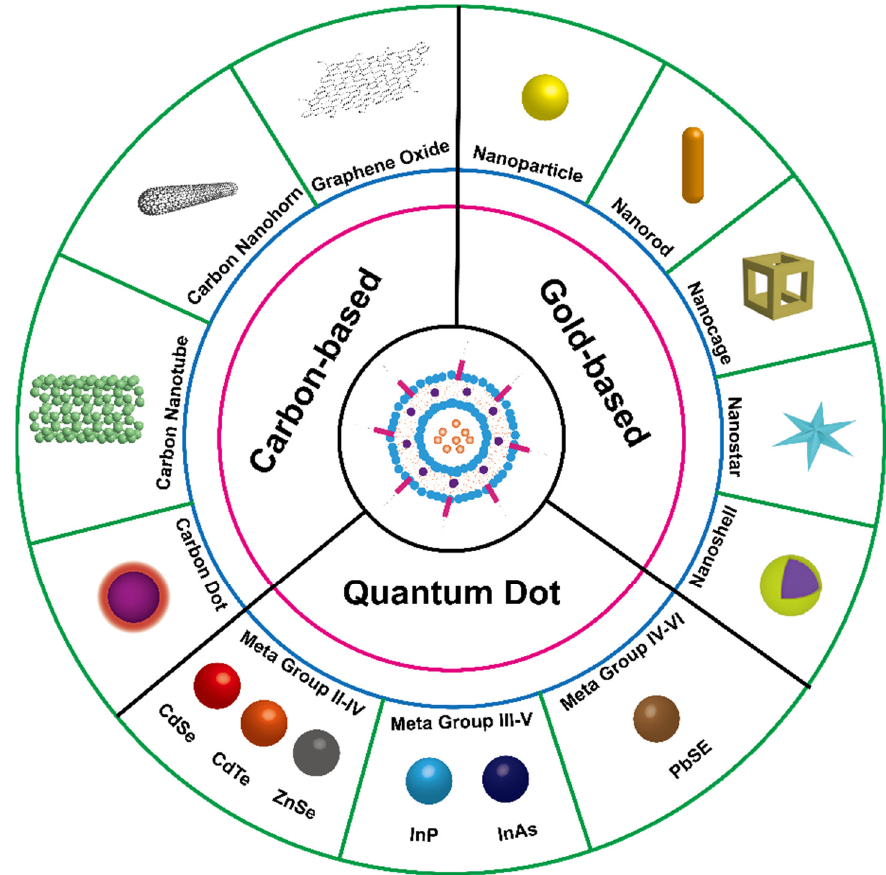
Figure 1. Schematic illustration of liposomes loading various NIRNs for cancer